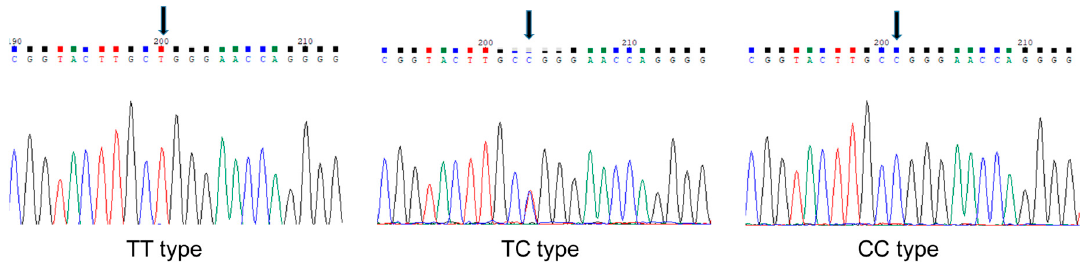
Figure 1. Polymorphic sites identified in the FANCA gene. Arrows indicate rs2239359 SNP.